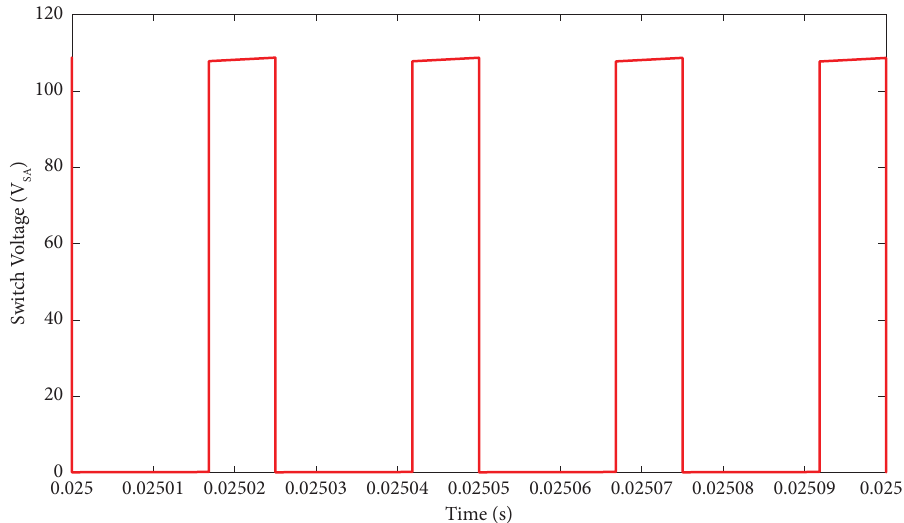
Figure 9: Te switch S A simulated voltage waveform.